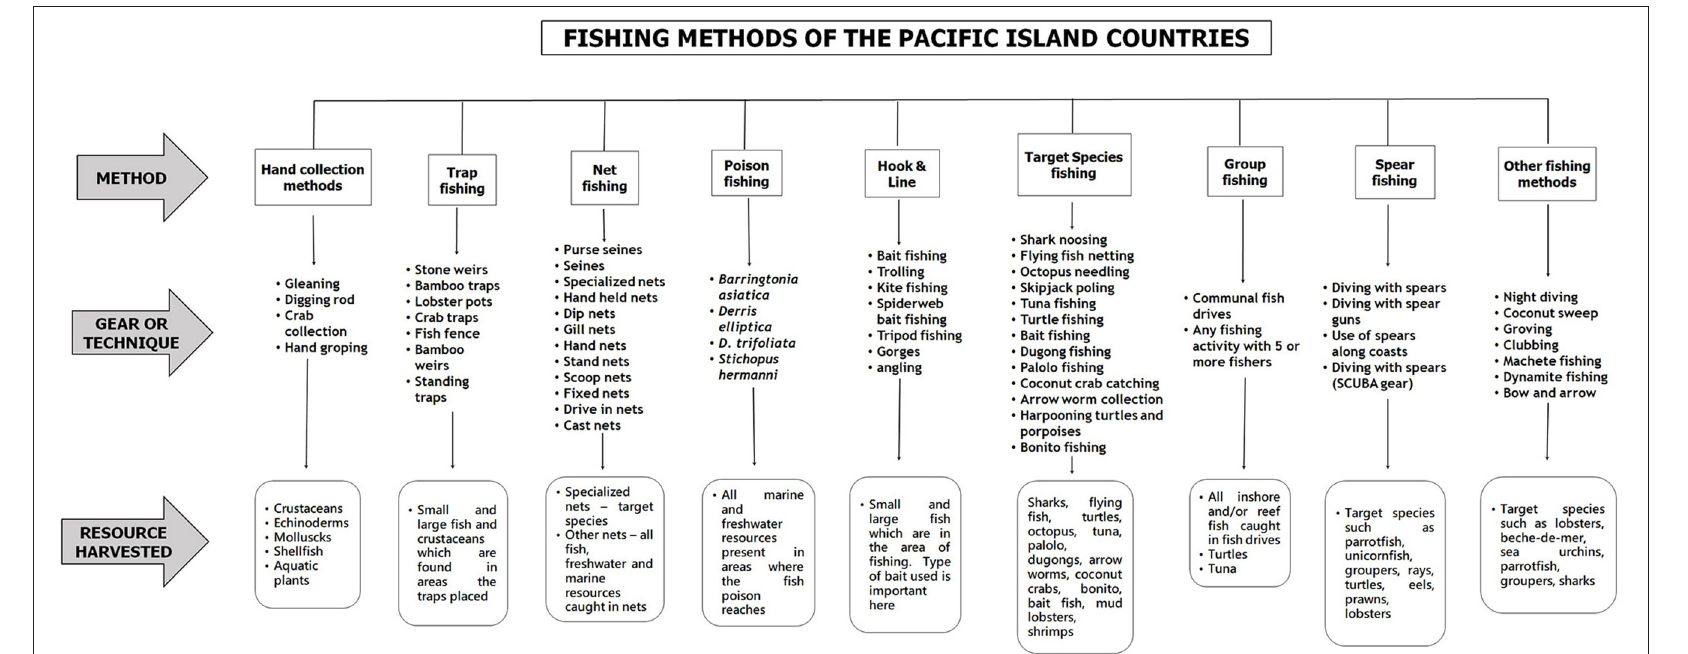
FIGURE 4 | Fishing methods, techniques and fishing gear of Fiji and other Pacific